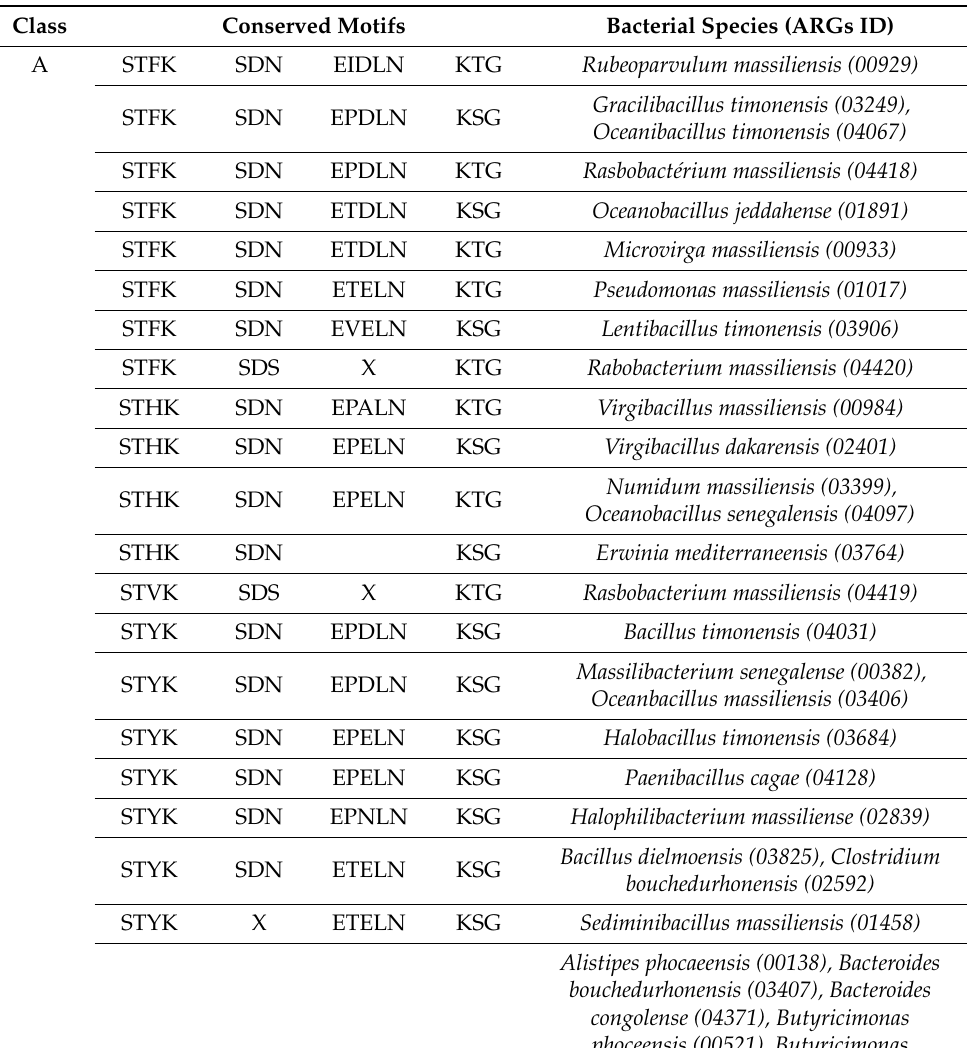
Table 2. ARGs with probable β -lactamase activity and the analysis of the conserved motifs to determine their nature, either serine (class A, C and D) or metallo (class